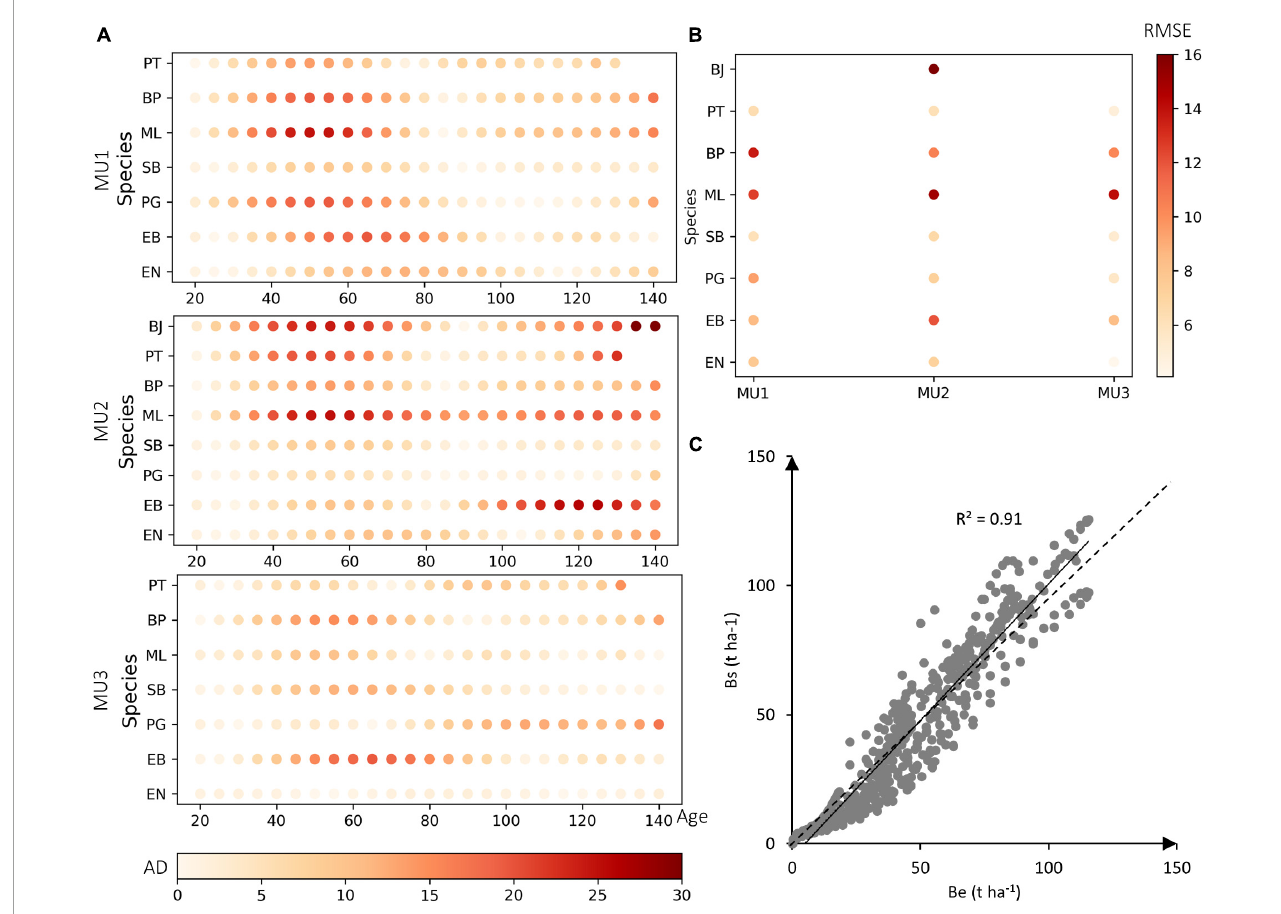
FIGURE2 (A) Calibration results of all species in the three MUs (MU1, MU2, and MU3), the color-bars present the absolute difference (AD) between empirical biomass ( B e ) and simulated biomass ( B s ) for 120 years per studied species (EN, black spruce; EB, white spruce; PG, jack pine; SB, balsam fir; ML, larch tree; BP, white birch; PT, trembling aspen; BJ, yellow birch). (B) The root-mean-square error (RMSE) between B e and B s in the three MU. (C) The correlation between all simulated and empirical values used for calibration, the dotted line represents the 1:1 ratio, and the continuous line represents the adjusted